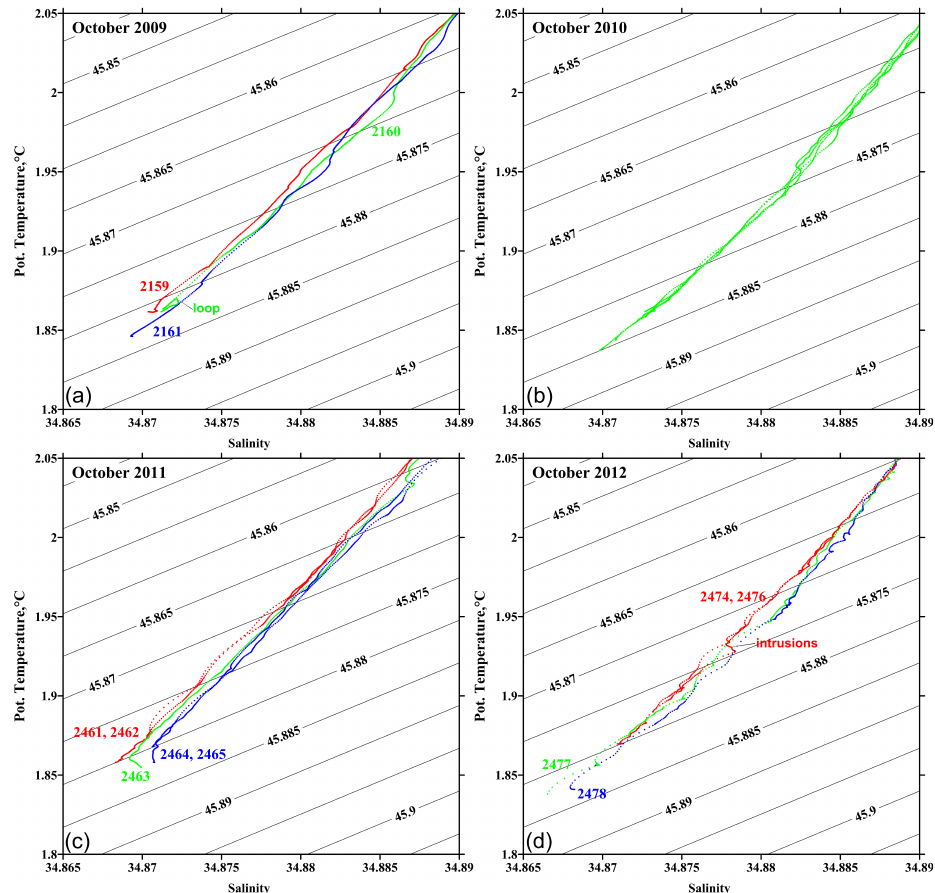
Fig. 9. 2 –S scatter plot of the bottom layer in the sections across the Kane Gap in October 2009 (a) , October 2010 (b) , October 2011 (c) , and October 2012 (d) . Isopleths of potential density σ 4 are also